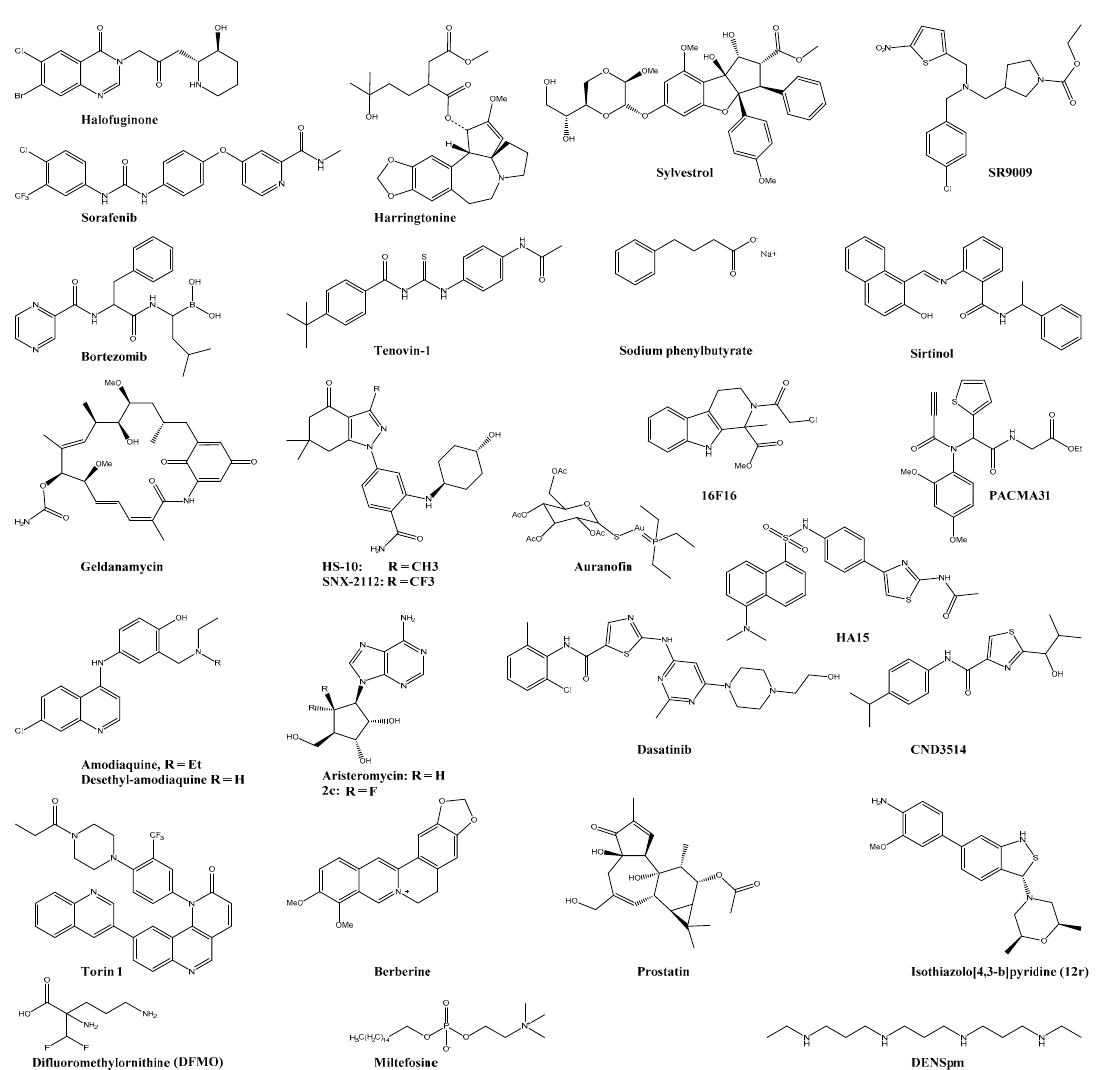
Figure 4. Chemical structure of selected host-targeting compounds. Inhibitor of the protein synthesis: halofuginone, harringtonine, sorafenib, sylvestrol, bortezomib, and SR9009. Inhibitor of cellular proteins: tenovin-1, sodium phenylbutyrate, sirtinol, geldanamycin, HS-10, SNX-2112, HA15, 16F16, PACMA31, and auranofin. Inhibitor of cellular enzymes: amodiaquine, desethyl-amodiaquine, aristeromycin, dasatinib, Torin 1, CND3514, berberine, miltefosine, prostatin, isothiazolo[4,3-b]pyridine, difluoromethylornithine, and